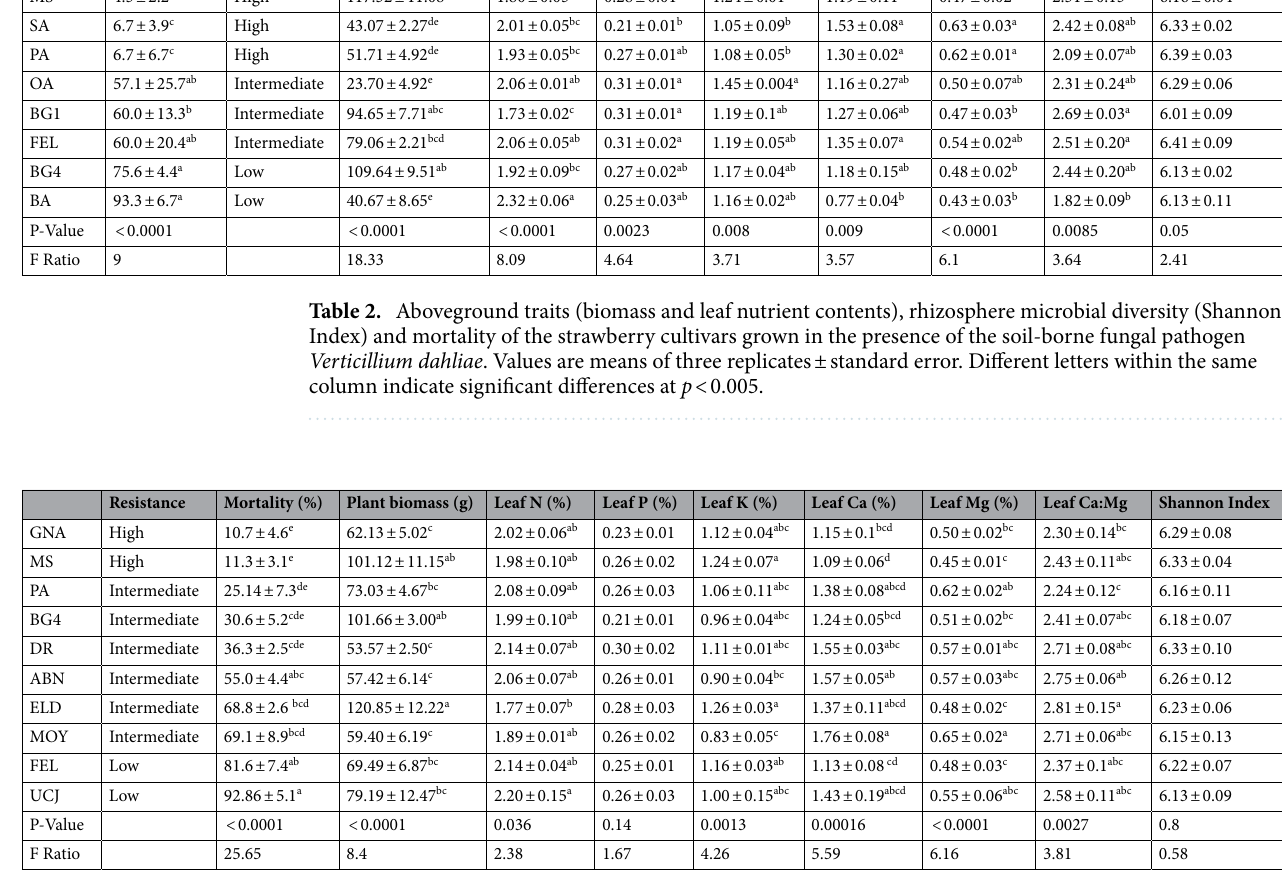
Table 3. Aboveground traits (biomass and leaf nutrient contents), rhizosphere microbial diversity (Shannon Index) and mortality of strawberry cultivars inoculated with Macrophomina phaseolina . Analysis of variance was used to compare groups. Different letters within the same column indicate significant differences at p <